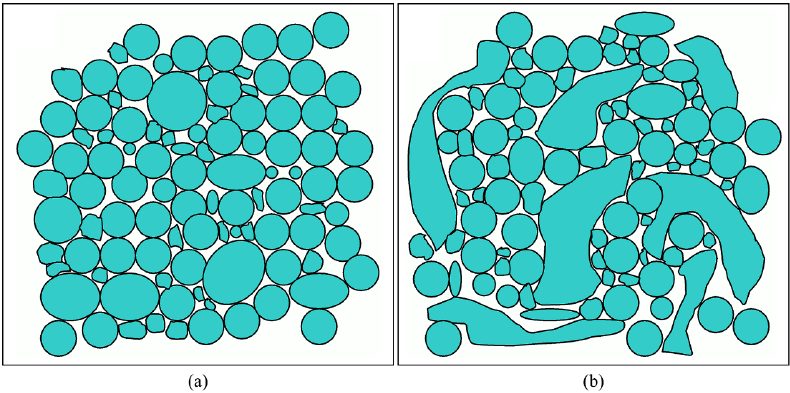
Figure 4. Microstructure models of (a) conventional and (b) modified ITO